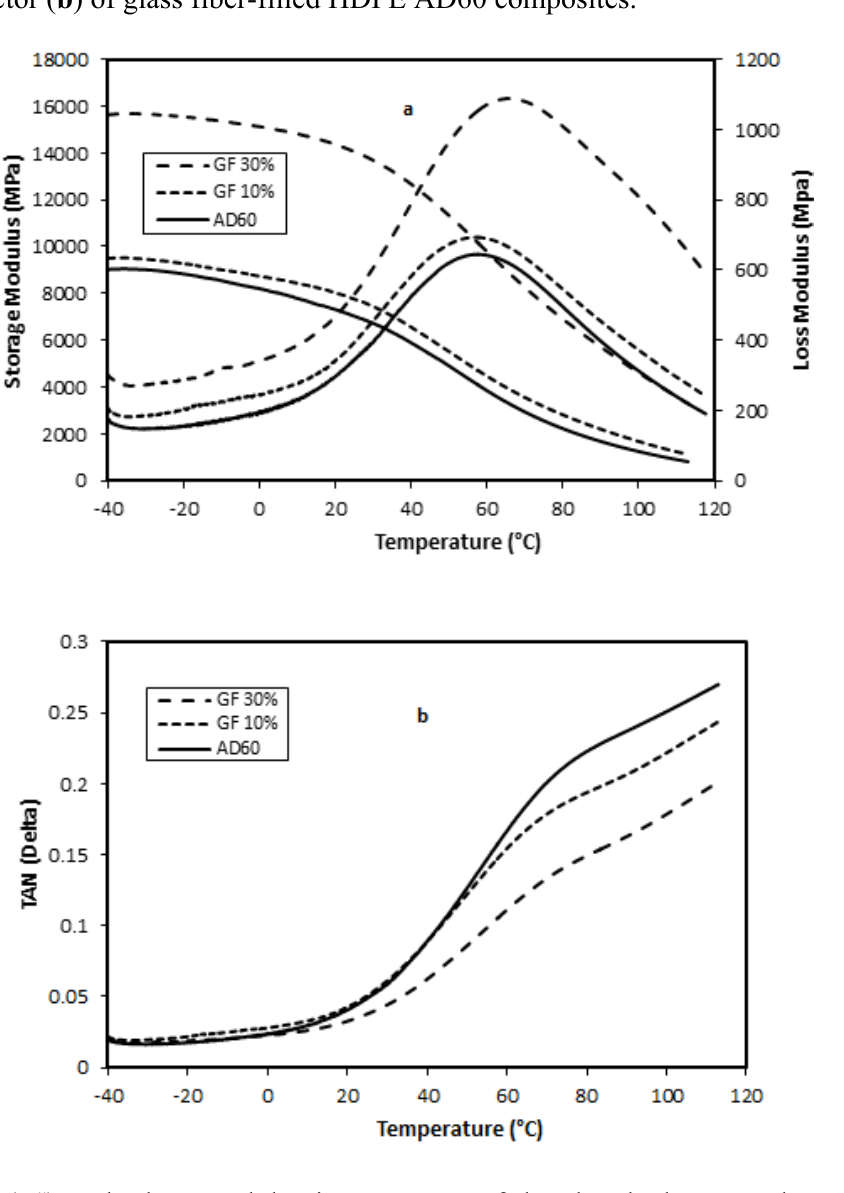
Figure 3. Effects of temperature level on storage modulus and loss modulus ( a ) and damping factor ( b ) of glass fiber-filled HDPE AD60